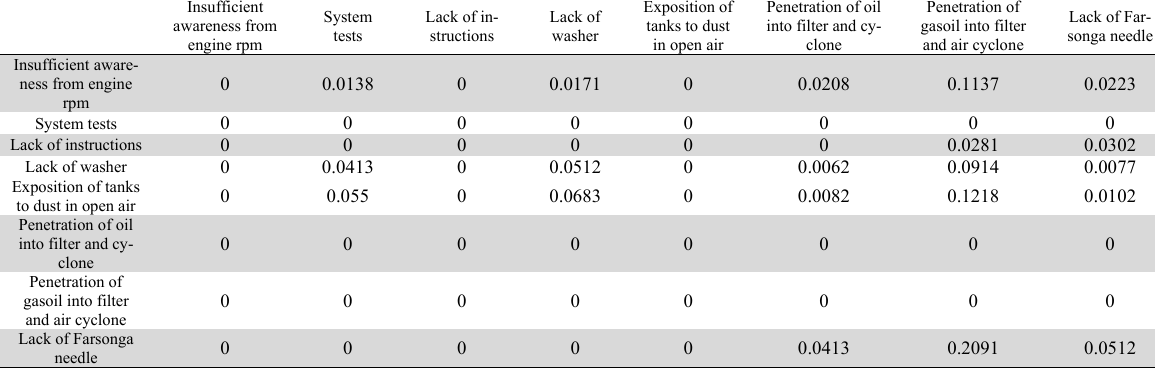
Matrix of undirected relation